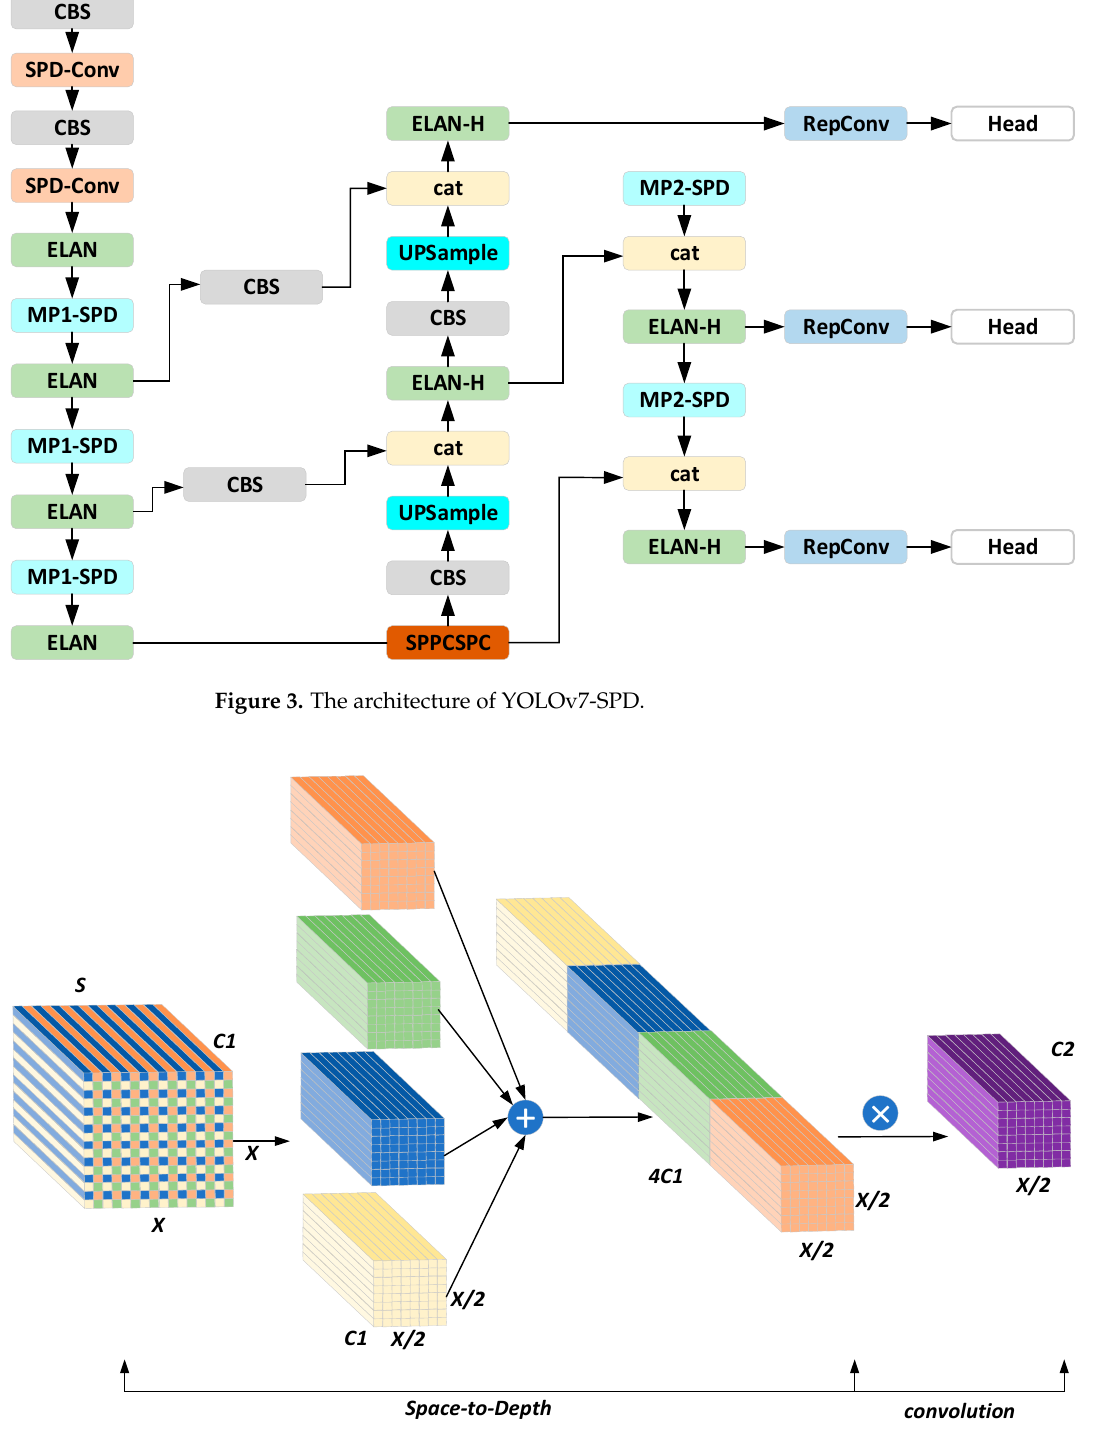
Figure 4. The architecture of space-to-depth (SPD) layer.